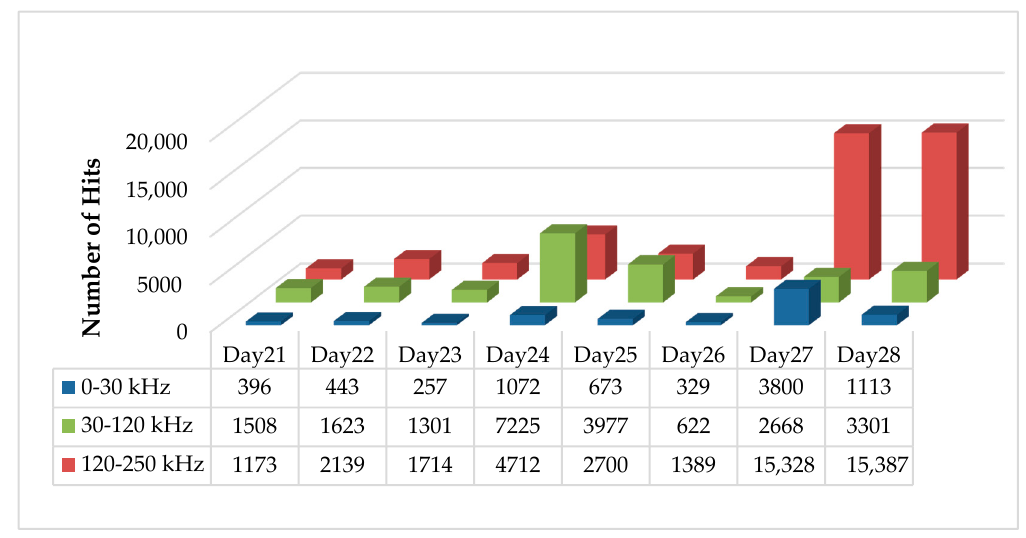
Figure 8. Number of events with peak frequency ranges 0–30 kHz, 30–120 kHz, and 120–250 kHz.